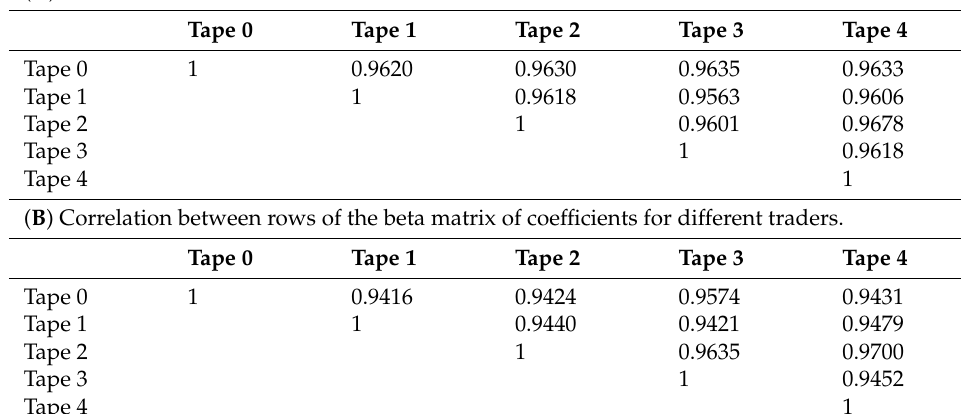
Table 2. Correlations in the complex beta matrices of the linear regression. ( A ) Correlation between columns of the beta matrix of coefficients for different traders. Tape 0 Tape 1 Tape 2 Tape 3